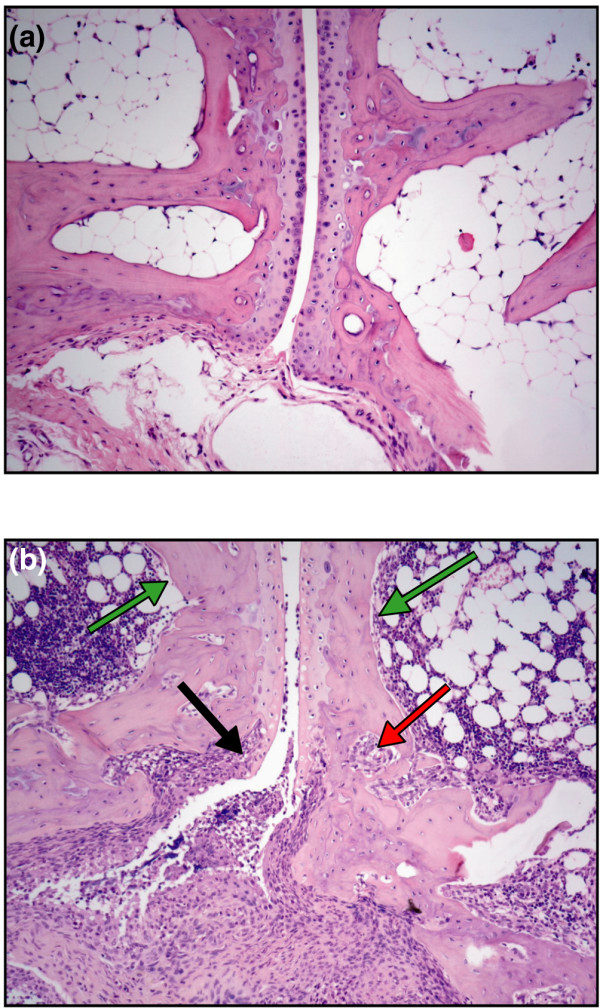
Synovial inflammation affects different compartments of juxta-articular bone. H & E-stained sections from the tarsal region of healthy 12-week-old (a) wild-type mice and (b) mice transgenic for human tumor necrosis factor (hTNFtg). The hTNFtg mice develop extensive synovial inflammation, cartilage damage and bone erosions. Three bone compartments affected by synovitis were analyzed in arthritic mice: the subchondral bone adjacent to the synovial inflammatory tissue (black arrow), the cortical bone channels in close vicinity of the inflamed areas (red arrow), and the endosteal bone surface distant from the inflammatory tissue (green arrows).